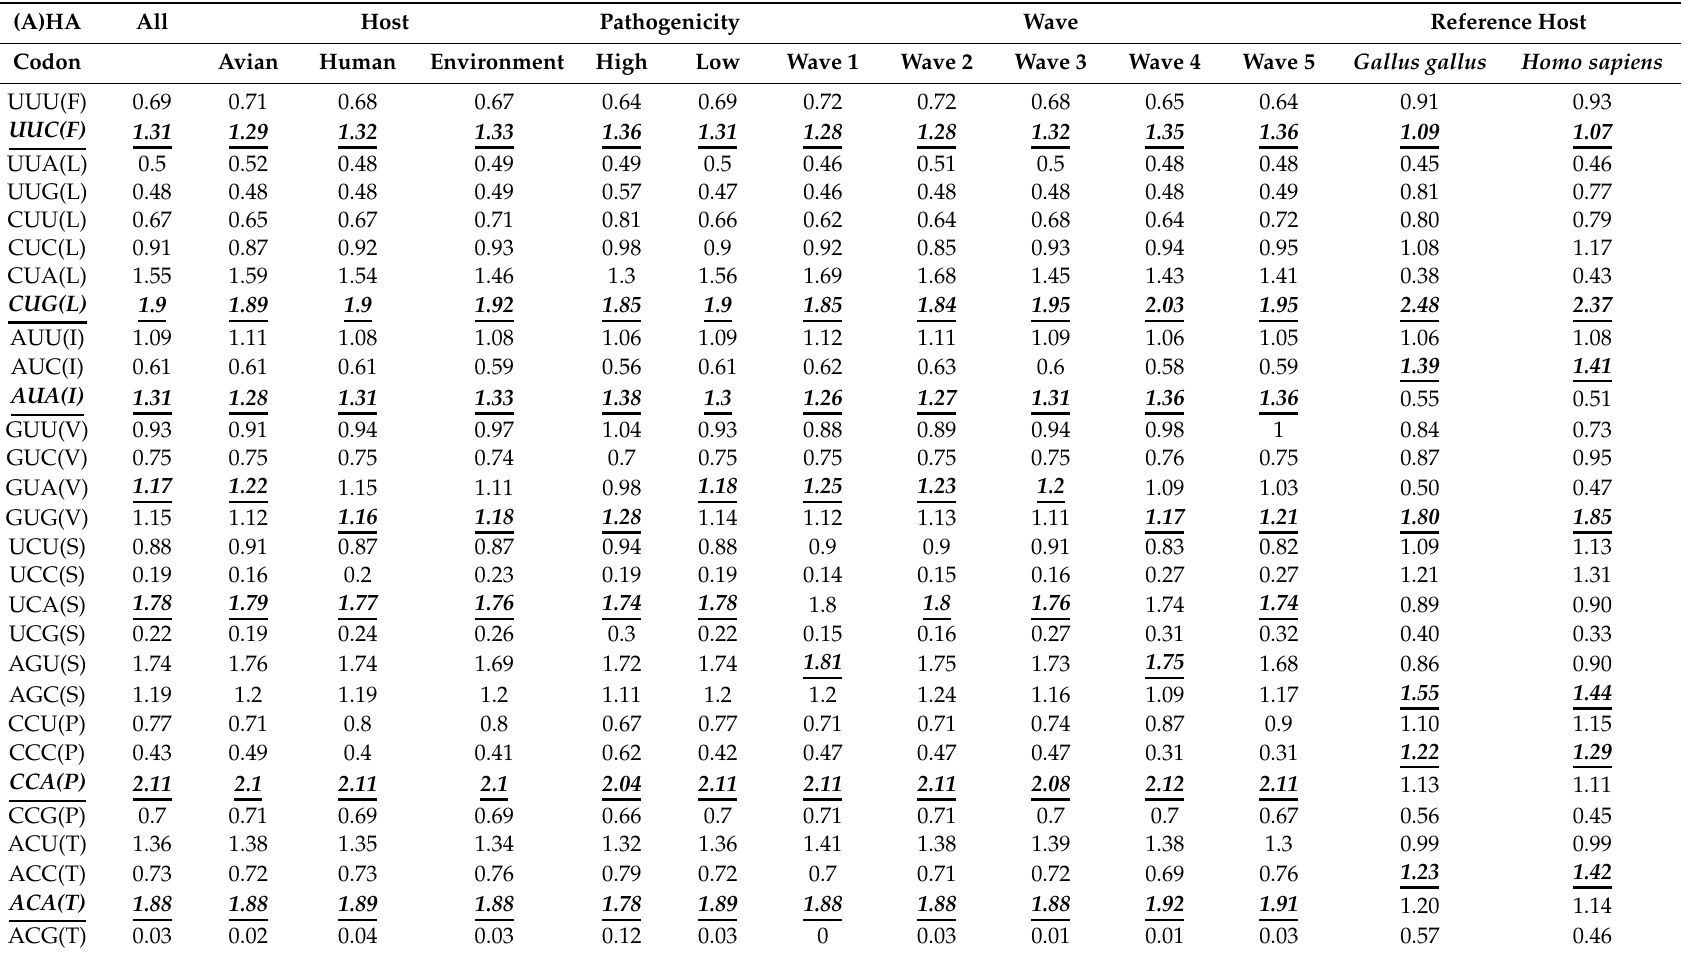
Table 2. Relative synonymous codon usage analysis (RSCU) analysis on the basis of HA, (A) and NA (B) of three classifications: host, wave, and pathogenicity, as well as the hosts Gallus gallus and Homo sapiens . For the best synonymous codon RSCU value, fonts are bolded and